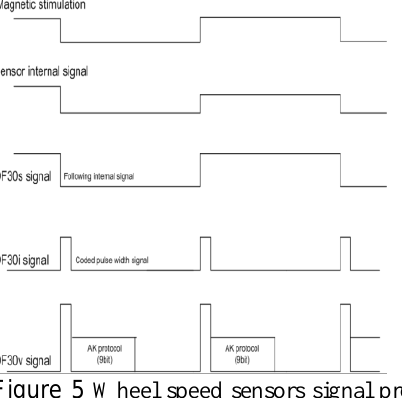
Figure 5 Wheel speed sensors signal protocol type s, i,